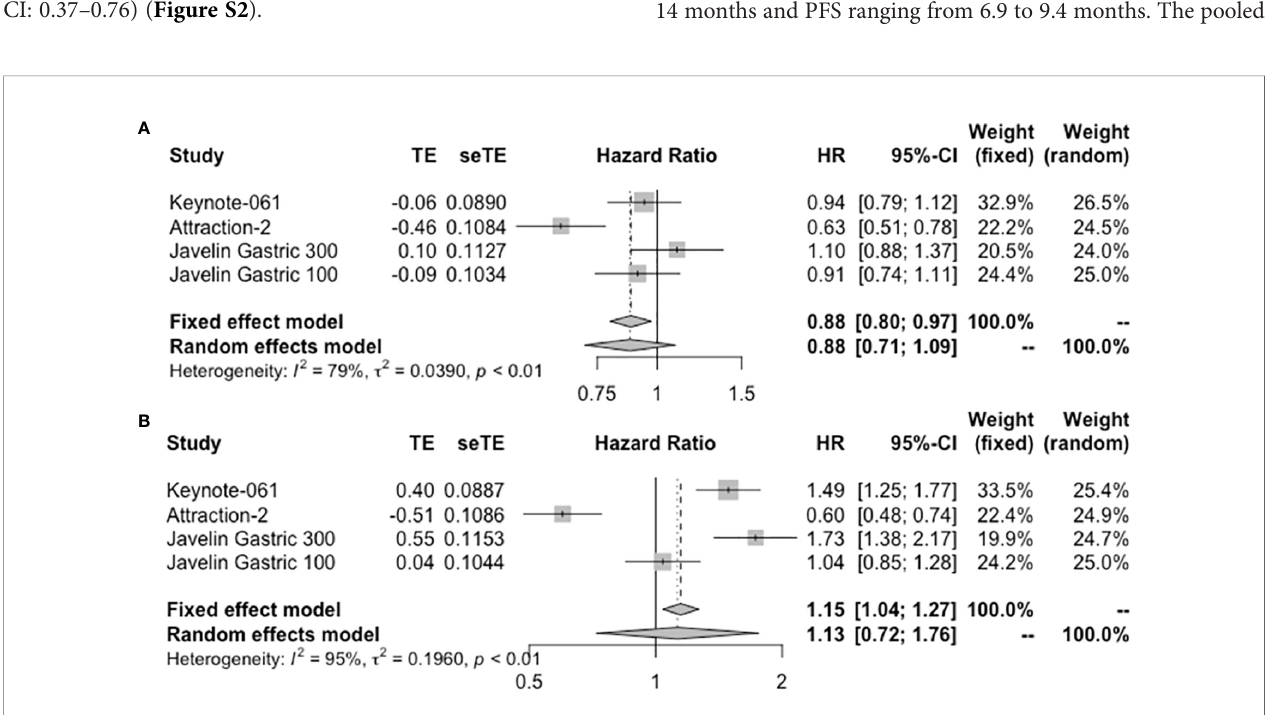
FIGURE 3 | Forest plot of (A) OS and (B) PFS in allover population receiving single-agent immunotherapy. OS, overall survival; PFS, progression-free